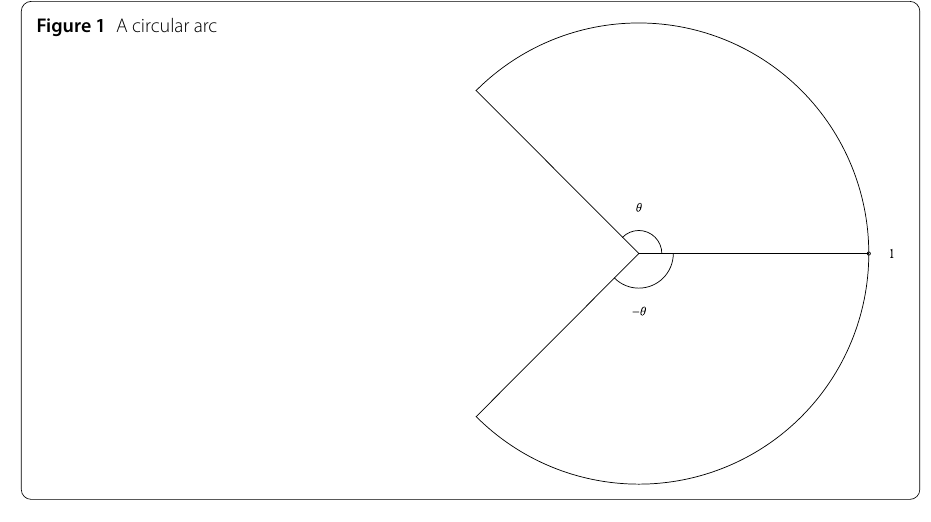
Figure 1 A circular